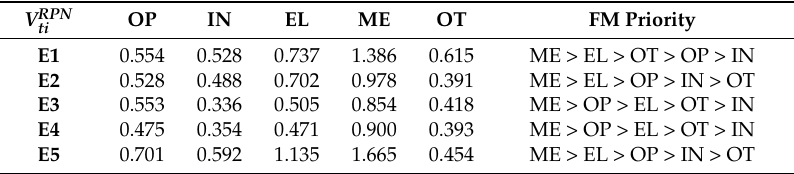
Table 3. The cluster linguistic risk priority number and ranking.